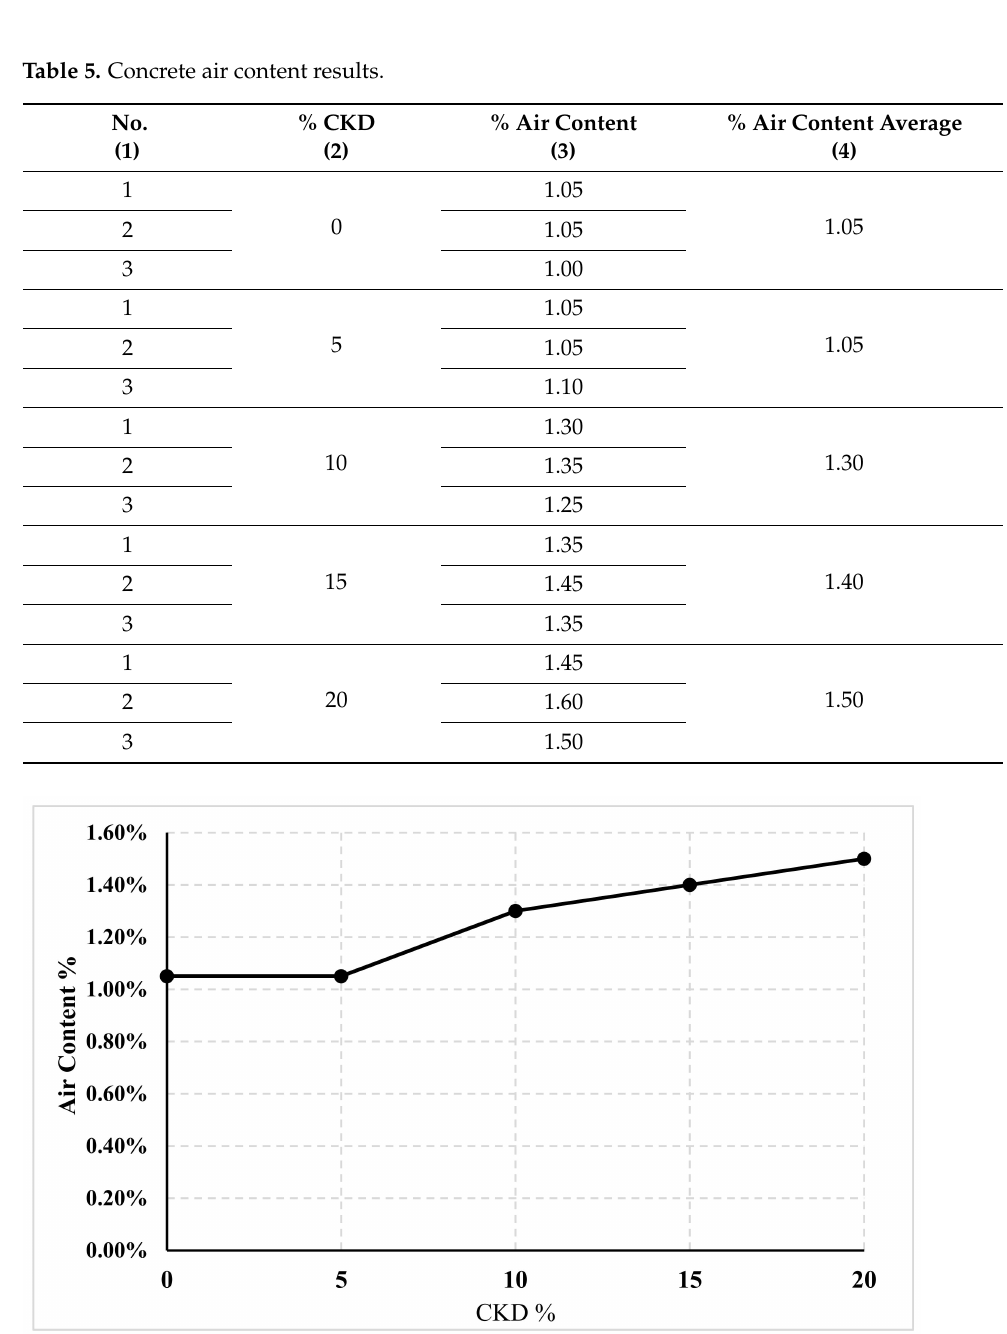
Figure 5. Relation between air content and CKD